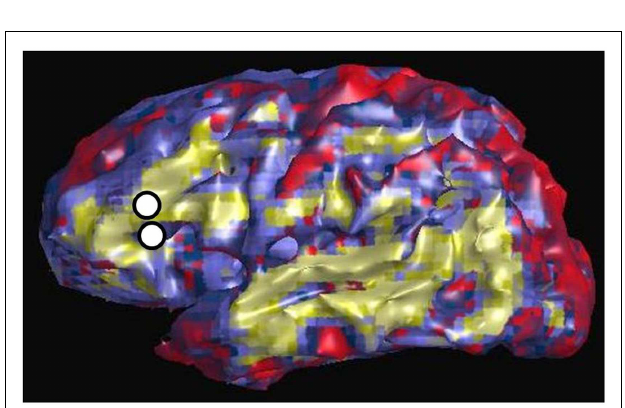
greater than 50mV; blue represents voltages less than − 50mV. A total of six images are shown with mean voltages taken from the displayed time intervals. Note the rapid evolution of voltage spread, which qualitatively follows the expected connection along the arcuate fasciculus.